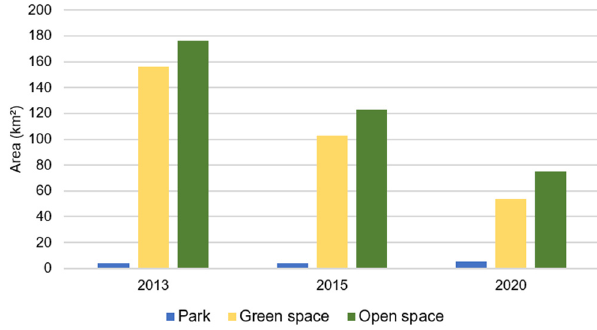
Figure 8. Area of open public space from 2013 to 2020 in Guilin.